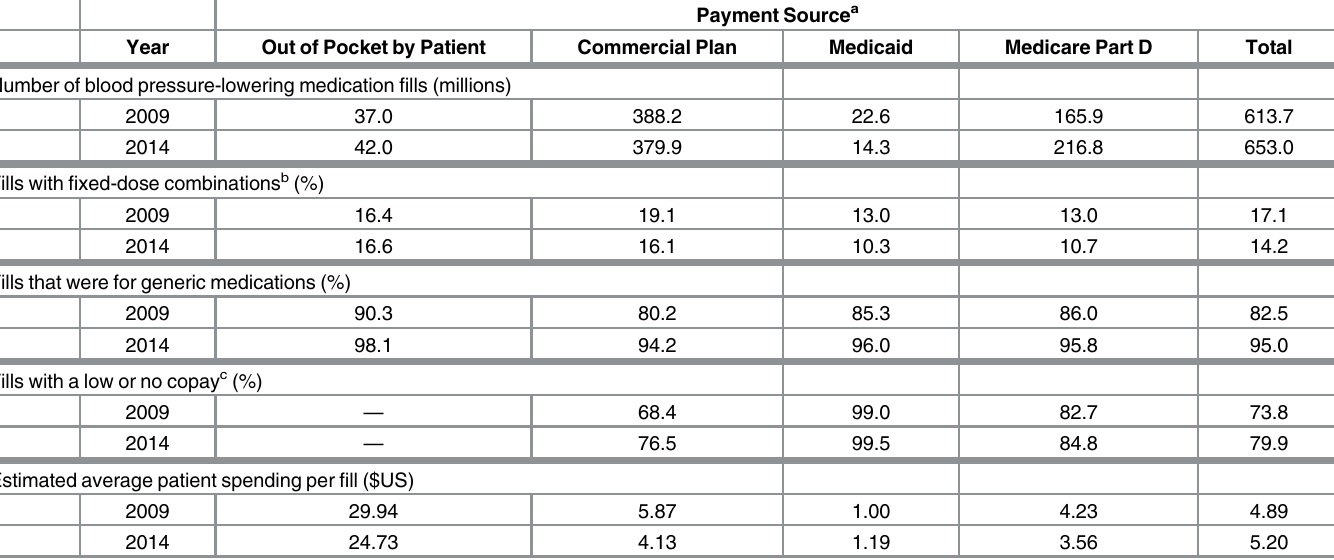
Table 2. Prescription- and payment-related Factors that Promote Adherence to Blood Pressure-lowering Medications by Payment Source, 2009 and